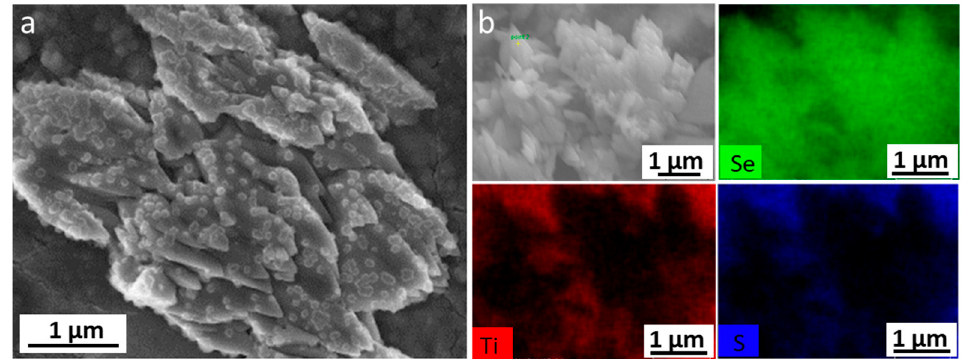
Figure 9. ( a ) SEM images and ( b ) EDX images of Li 2 TiSe 2 S electrodes charged to 3 V and kept for 24 h.